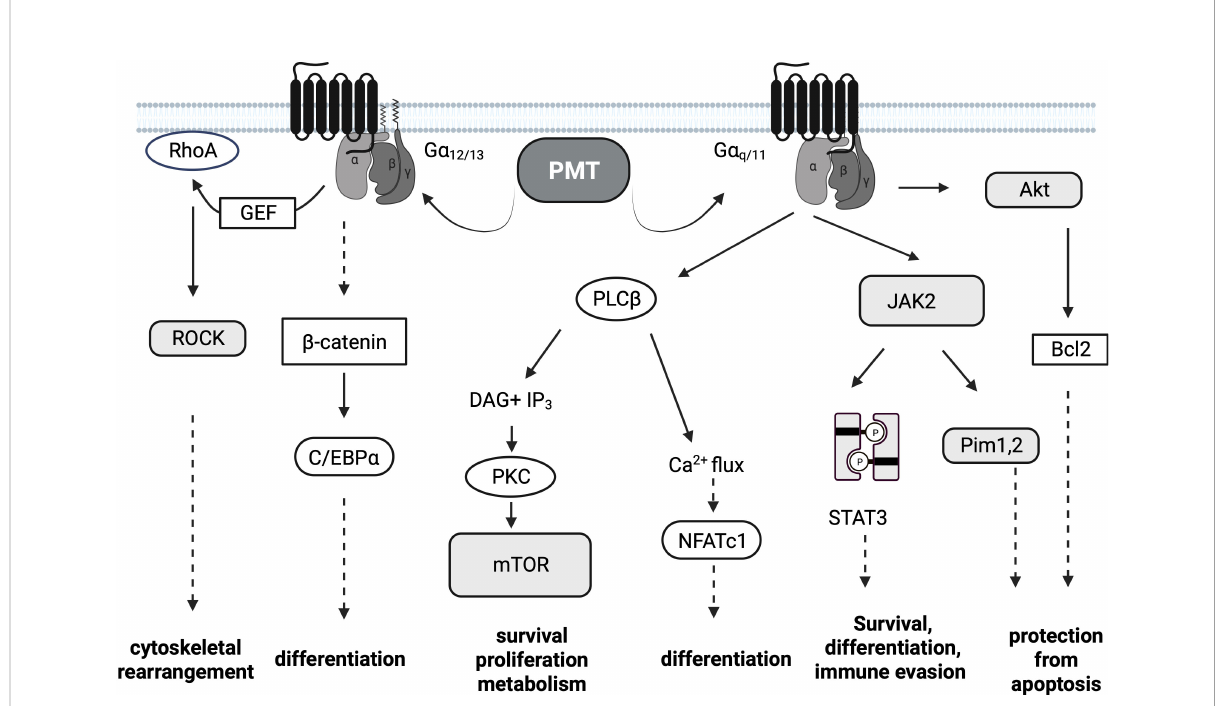
FIGURE 1 PMT Signaling. Pasteurella multocida toxin (PMT)-dependent signaling pathways. PMT modi fi es the G a subunits of the heterotrimeric G proteins G a i, G a q/11 and G a 12/13 through deamidation. The major subsequent signaling pathways downstream of G a q/11 and G a 12/13 are depicted. Transcription factors are depicted in white oval boxes, kinases in shaded boxes. Dotted arrows are used if the activation of the depicted molecules is not directly